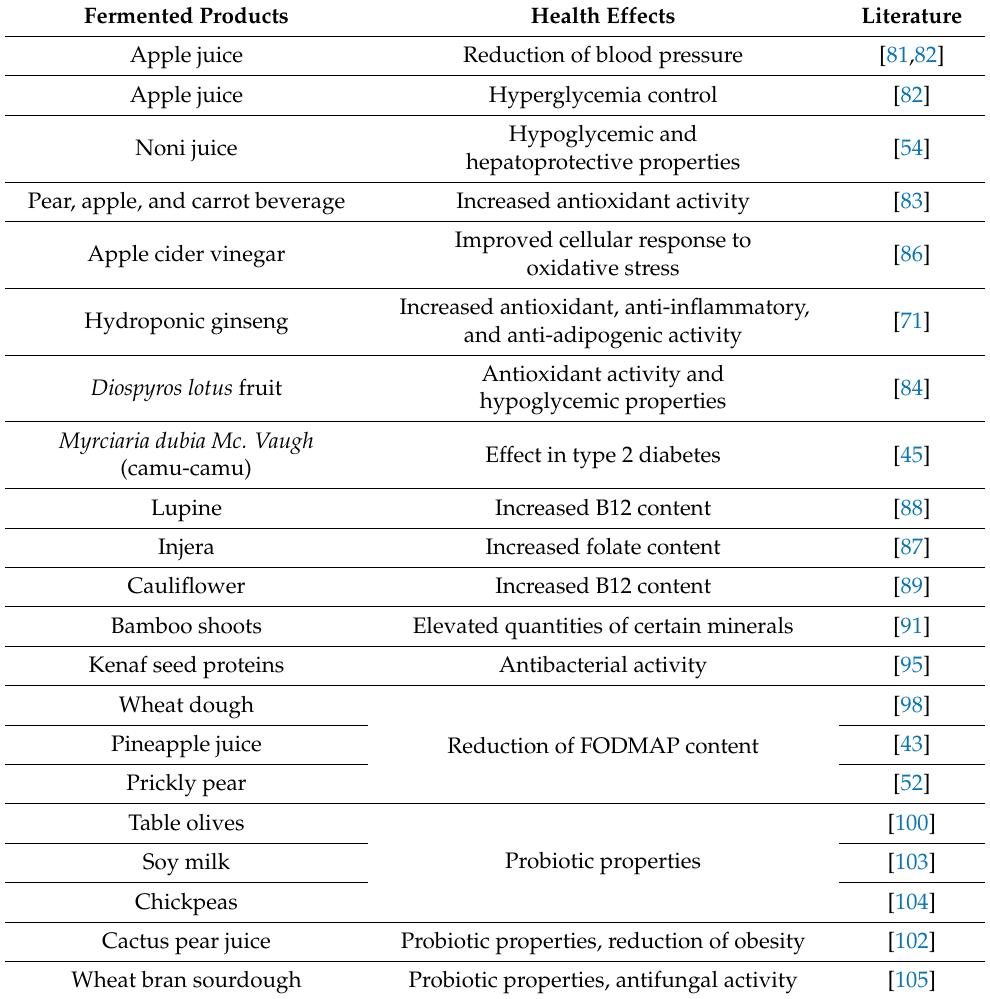
Table 2. Summary of plant-based fermented foods and their health effects.